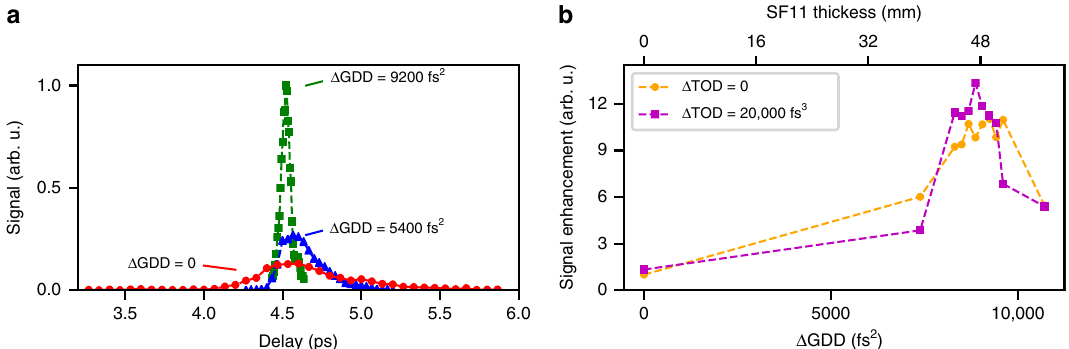
Fig. 3 Optimisation of the relative spectral phase. a Scan of pulse delay to match Δ ω to the PPLN frequency Ω THz . Adding Δ GDD, by inserting SF11 into one of the interferometer arms, the THz signal increases up to a factor of 11 (green squares), and the range of THz-generating delays narrows. b Conversion ef fi ciency enhancement vs Δ GDD for varying amounts of Δ TOD. For an optimum Δ TOD, the signal increases by another 20% relative to no Δ TOD correction, yielding a total increase in THz output by a factor of